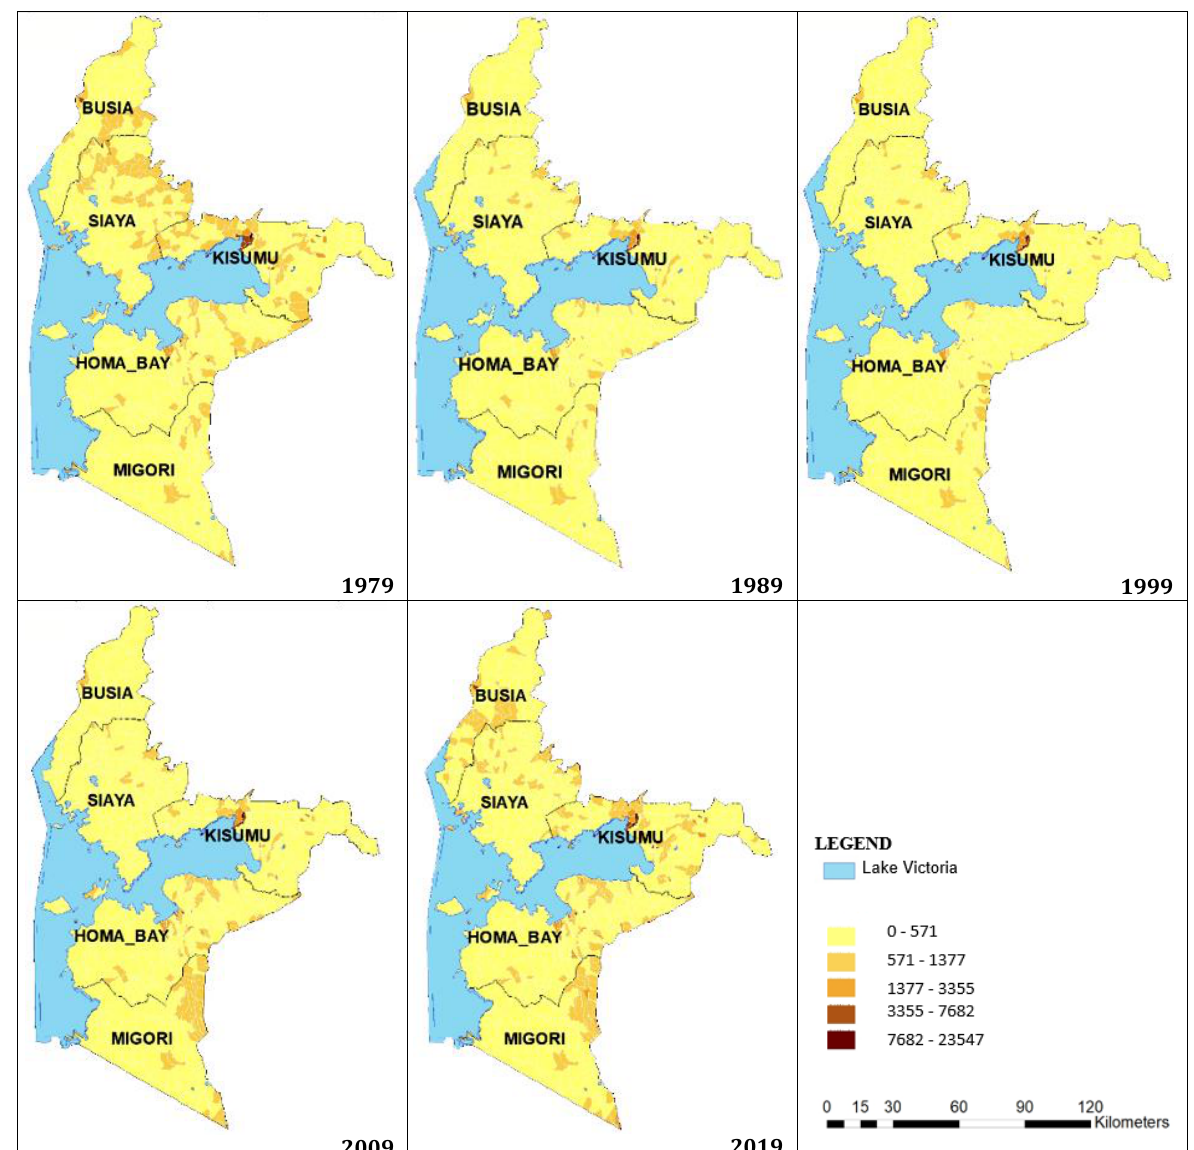
Fig. 7. Population density in the Lake Victoria Basin for 1979, 1989, 1999, 2009 and 2019